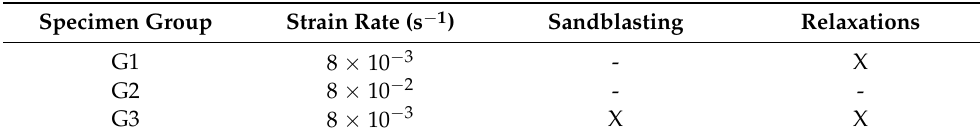
Table 1. Test conditions for each specimen